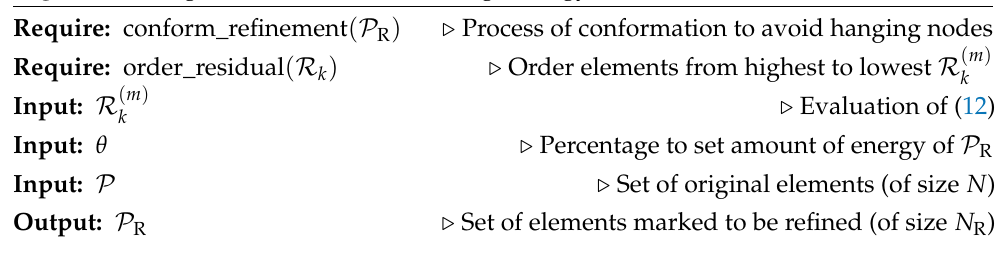
Algorithm 5 Slight variation of the marking strategy in